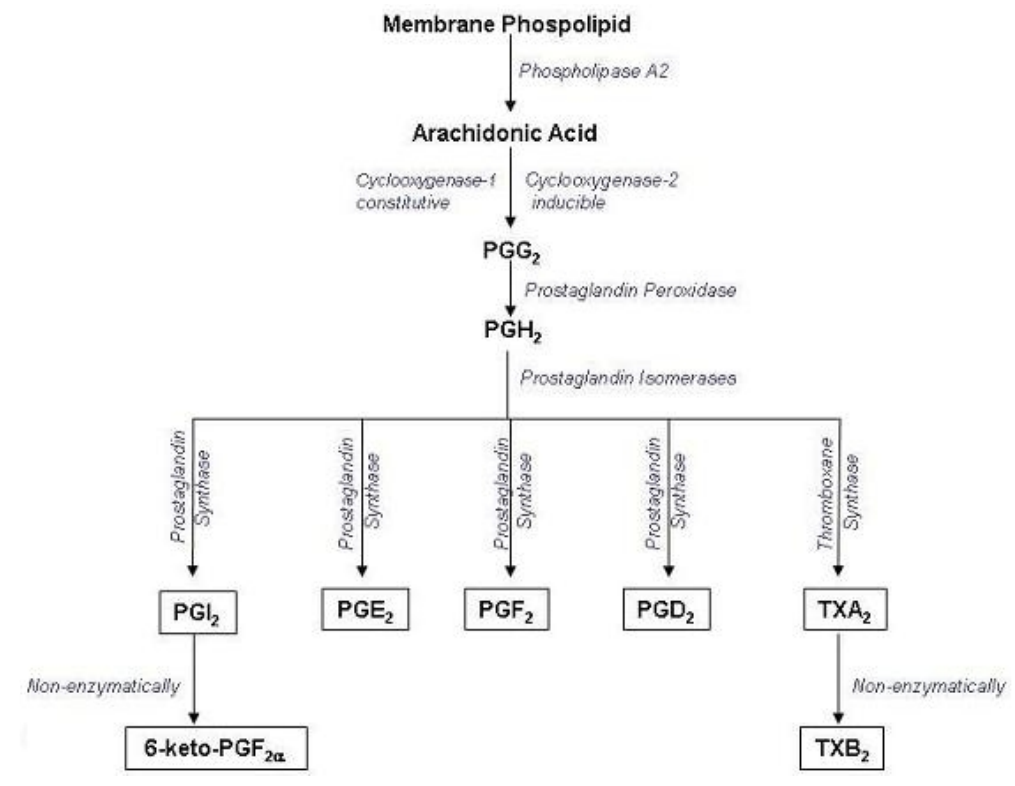
Figure 5. Schematic representation of arachidonic acid metabolism in platelets through cyclooxygenase that catalyzes the synthesis of prostaglandins, thromboxane A